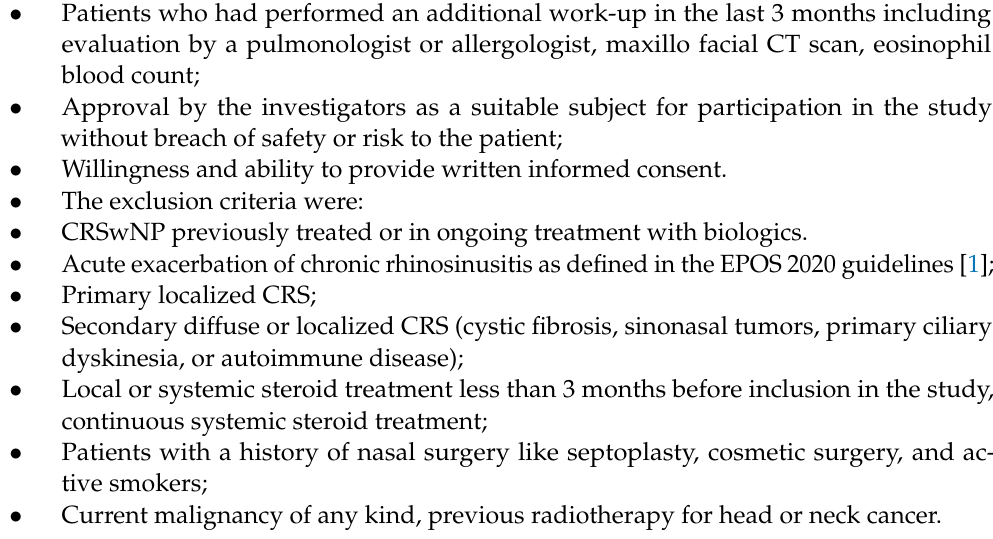
Table 1. Clinical characteristics of the studied